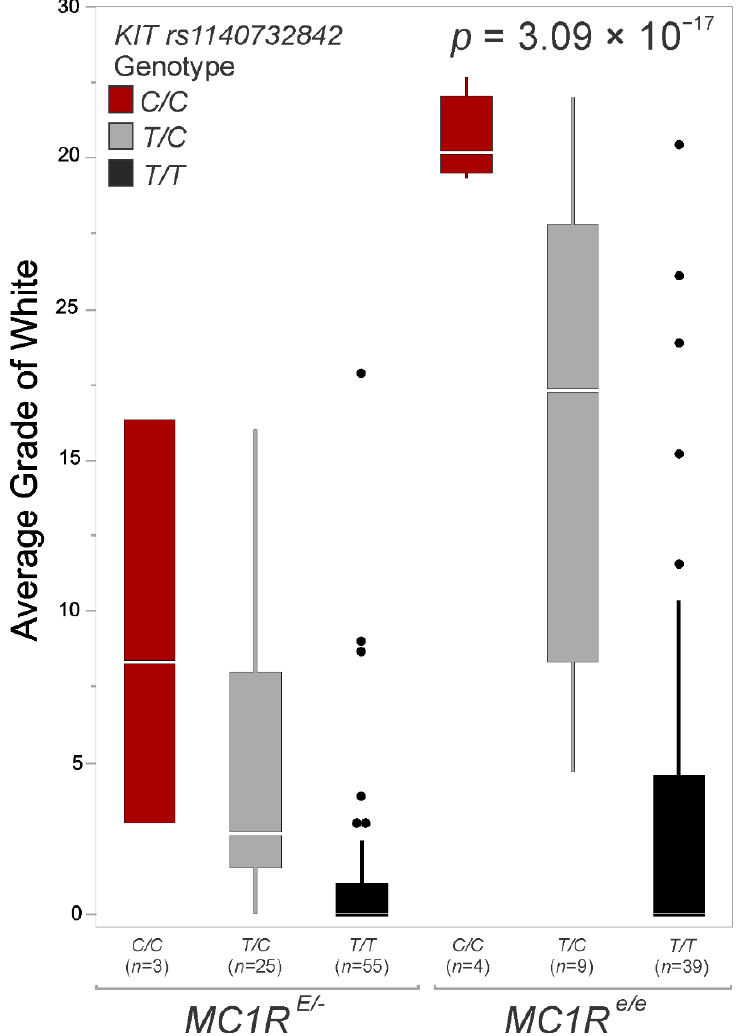
Figure 3. Genotype distribution of the rs1140732842 polymorphism in 135 individuals by Average Grade of White and MC1R genotype (black/chestnut).